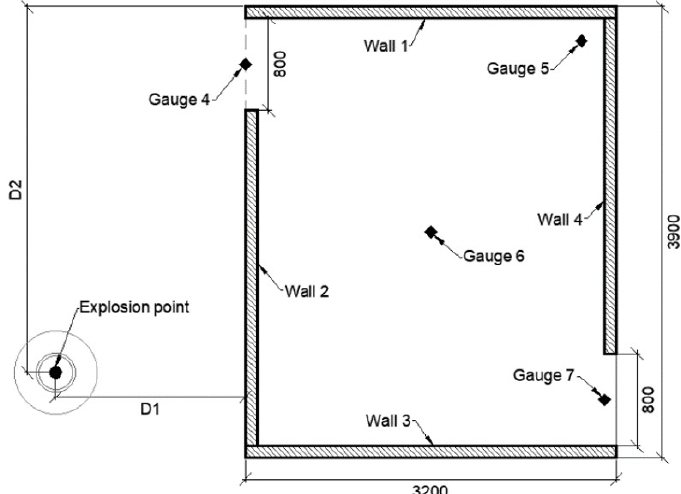
Figure 3. Floor plan for models 1 and 2 (All dimensions are in